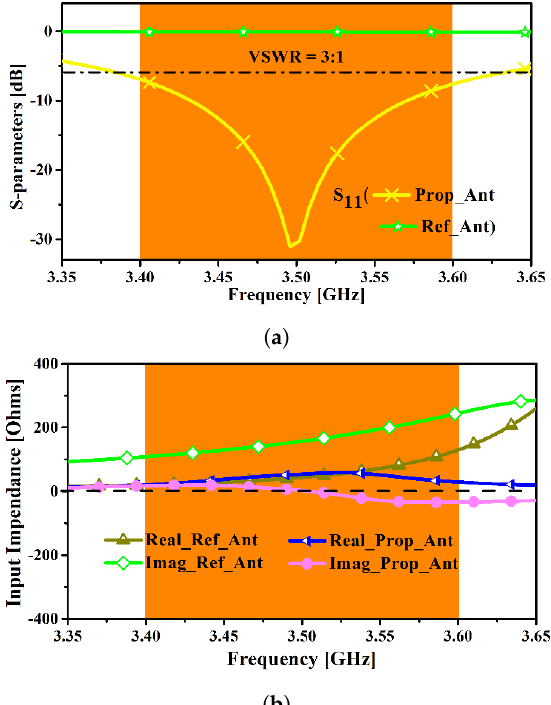
Figure 3. ( a ) Simulated Scattering S-Parameters for the unit slot antenna. ( b ) Input impedance